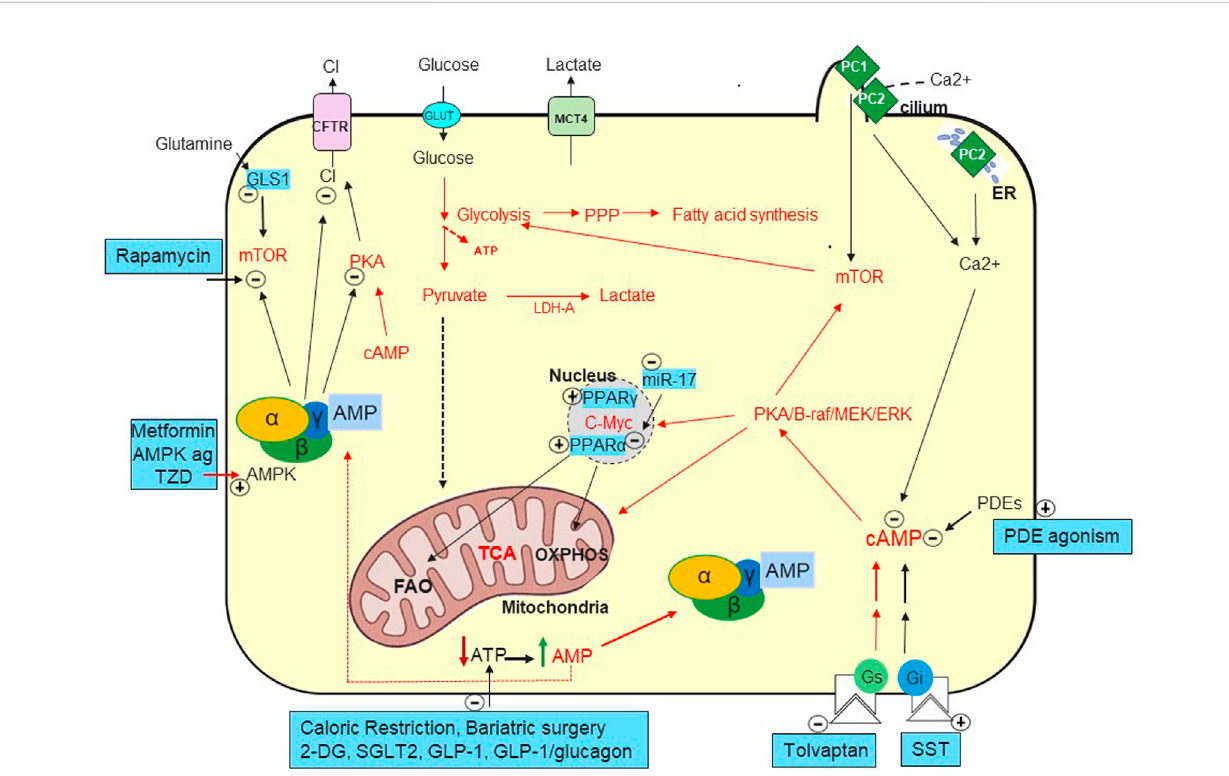
FIGURE 1 Metabolic Pathways in ADPKD. Increased cAMP due to vasopressin (Chebib et al., 2015) but likely also to decreased phosphodiesterases (PDEs) (Pinto et al., 2016) play a key role in generating fl uid- fi lled cysts. Defects in PC1 and PC2 mediated calcium ion in fl ux in the primary cilia and/or in the endoplasmic reticulum (ER) (Nauli et al., 2003; Padhy et al., 2022). Decreased intracellular calcium seems to convert the antiproliferative to proliferative effect of cAMP (Yamaguchi et al., 2003) causing activation of MEK-ERK and increased cell proliferation. cAMP activates PKA and stimulates chloride secretionthroughthecystic fi brosistransmembraneconductanceregulator(CFTR)(Sullivanetal.,1998).Tolvaptan,avasopressinV2receptorantagonist, was approved to preserve kidney function by targeting cAMP (Chebib and Torres, 2021). Several somatostatin analogues (SST) are being investigated to lower cAMP with Ocreotide-LAR being approved in ADPKD in Italy (Capuano et al., 2022a). Mammalian target of rapamycin (mTOR) and c-Myc are upregulatedinADPKD andsuppressoxidativemetabolismwhile enhancingglycolytic fl ux,lactateproductionandexport(LDH-AandMCT4)(Roweetal., 2013; Podrini et al.,